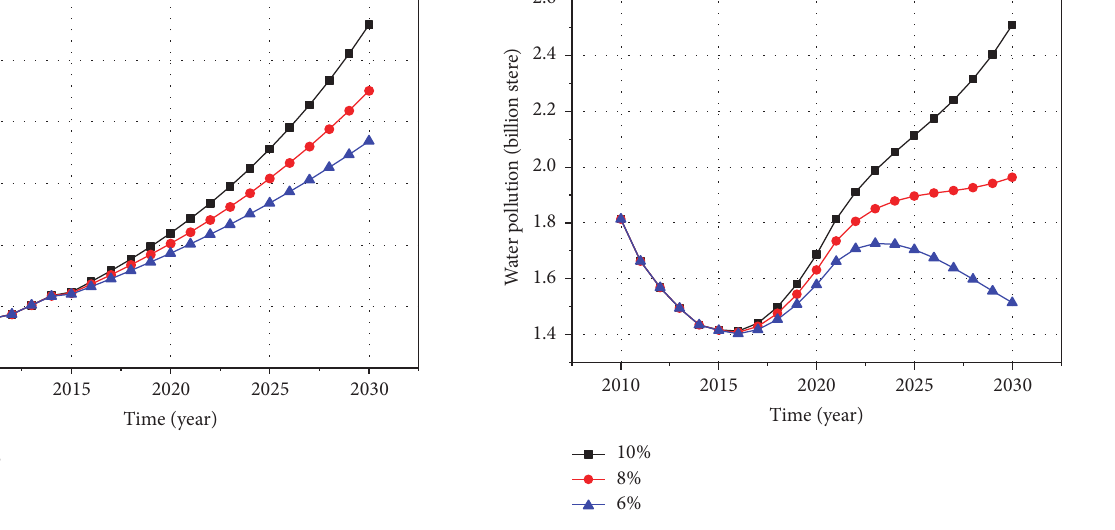
Figure 6: Total wastewater under different GDP growth rate. Figure 7: Water pollution under different GDP growth